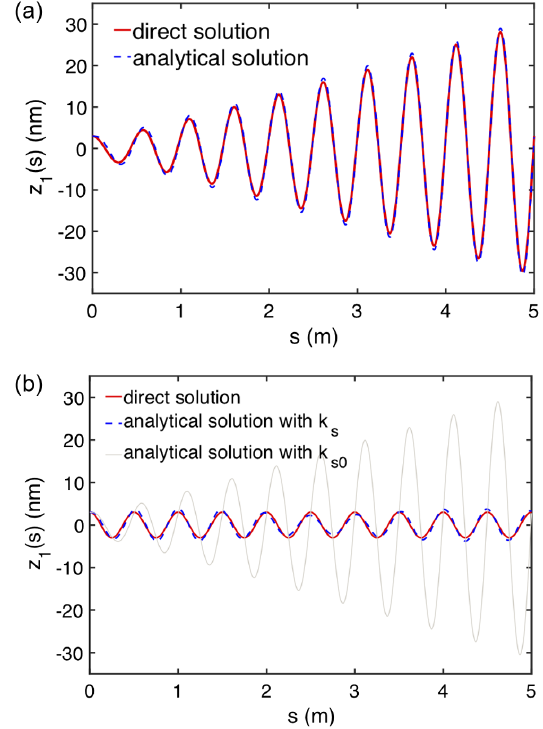
FIG. 3. Solutions to the first macroparticle. (a) Without potential-well effect, the red curve from Eq. (21) with k ¼ k s s 0 and the blue dashed curve from Eq. (27). (b) With potential-well effect, the red curve from the same Eq. (21) with k s given by Eq. (22) and the blue dashed curve from Eq. (26). For reference purposes, the gray curve in (b) is identical to the blue dashed curve in (a). The slippage effect is included in all the cases. Here ˆ z 1 ð 0 Þ ¼ 3 nm, K ¼ 4 . 2 , λ w ¼ 2 cm,